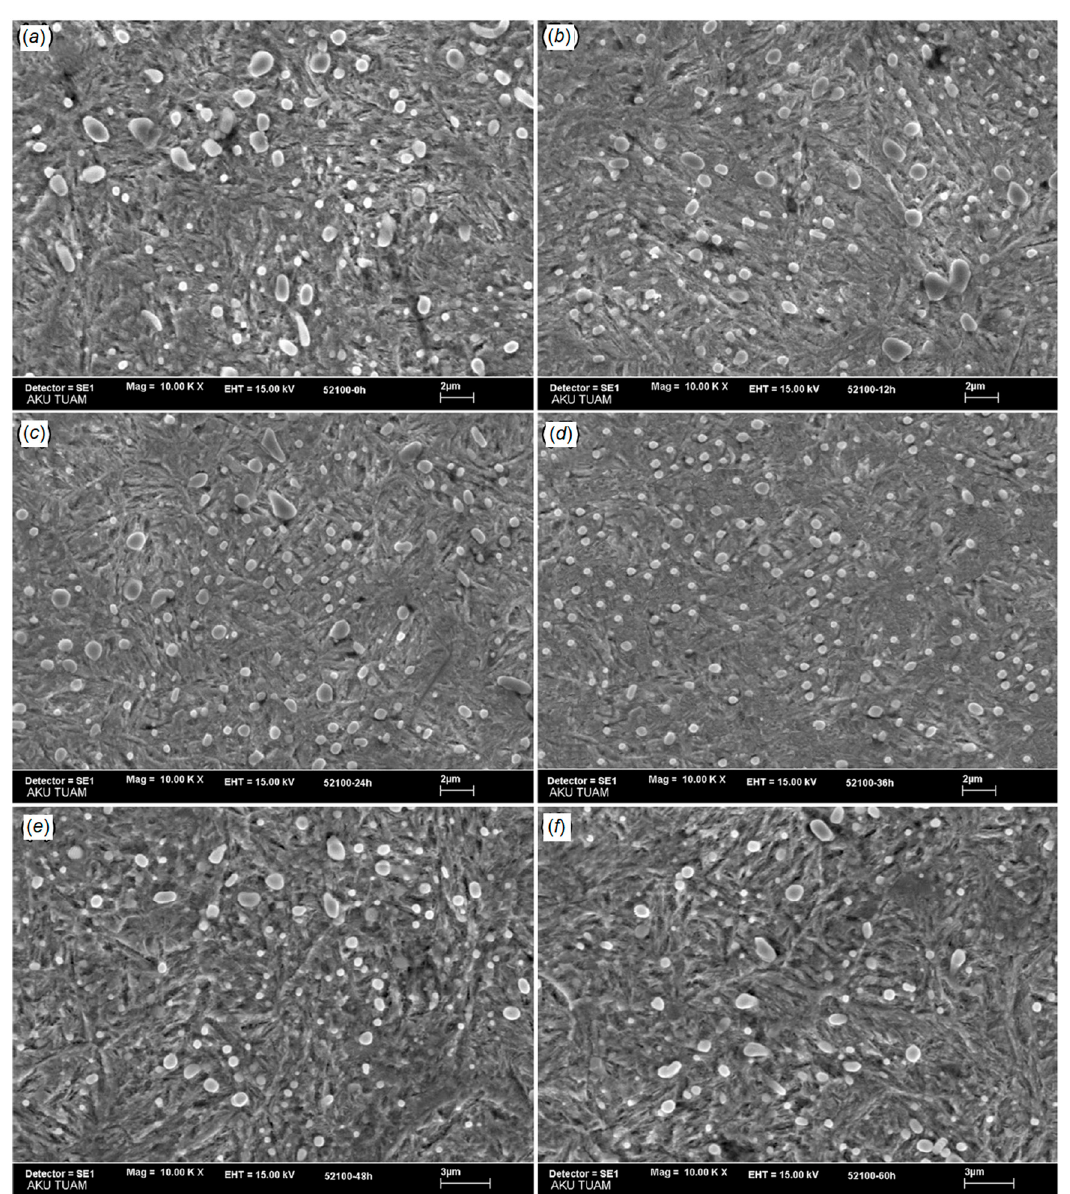
Figure 11. SEM microstructures of (a) CHT, (b) DCT-12 h, (c) DCT-24 h, (d) DCT-36 h, (e) DCT-48 h, and (f) DCT-60 h samples [92].